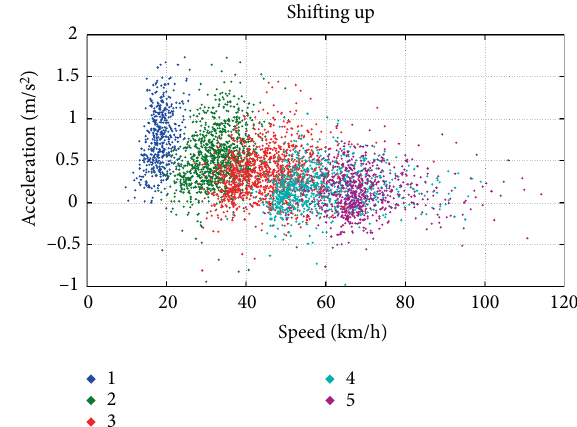
Figure 8: Acceleration and speed at actual gear shifts from different gears from field trials in Sweden using a Volvo V70 (6 gears